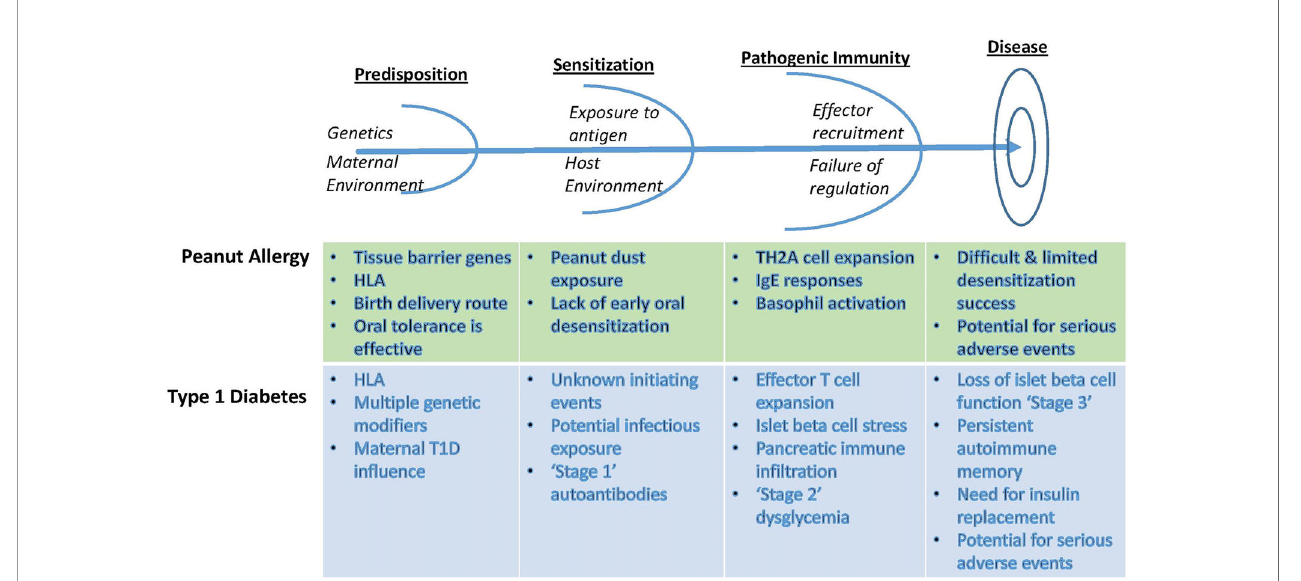
FIGURE 1 | Conceptual parallels between the approach to autoimmunity and allergy tolerance trials, using examples from T1D and from peanut allergy. Identi fi cation of early at-risk children allows for prevention strategies that rely on antigen exposure in the context of immune deviation or anergy. After initial antigen sensitization, however, additional measures are required to blunt effector responses to inhibit immune ampli fi cation events. Failing this, determinant spreading elicits robust immunity that recruits additional effector pathways and conditions in fl ammatory innate tissue responses, now requiring combinations of targeted therapeutics to ‘ reset ’ the immunological threshold and enable an opportunity to reestablish homeostatic balance between regulatory and effector pathways. Recognition of these differences requires appropriate staging and monitoring in order to select therapeutic options with tolerogenic